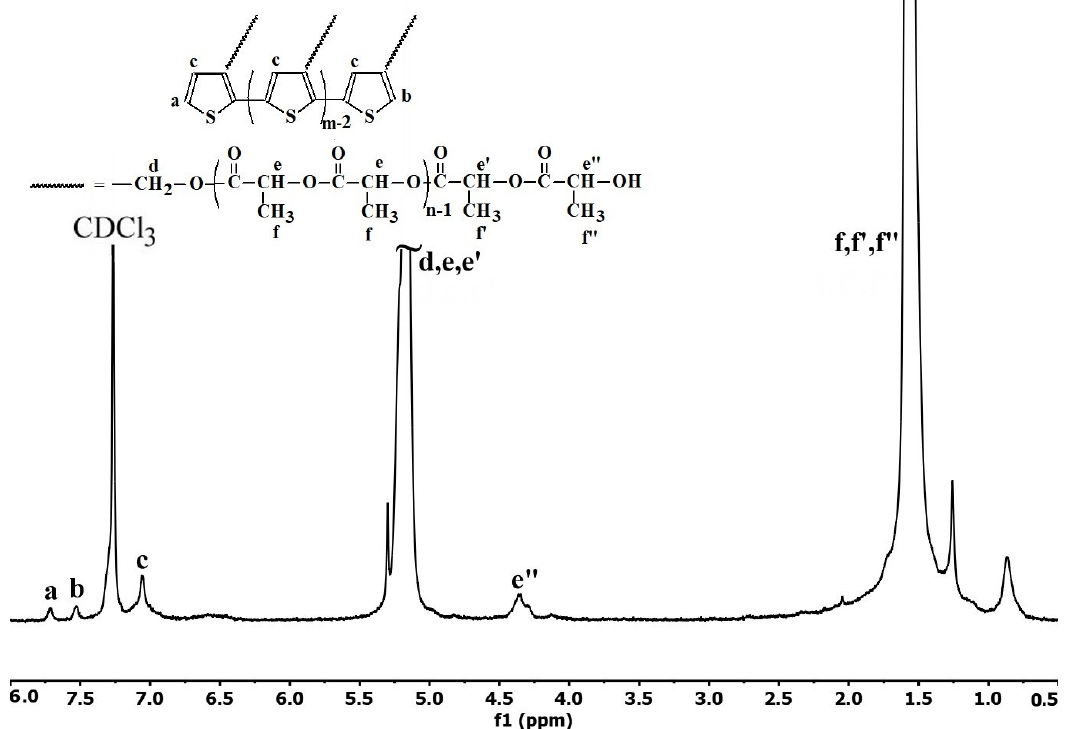
Figure 4. The 1 H-NMR spectrum of the OTh-PDLLA recorded in CDCl 3